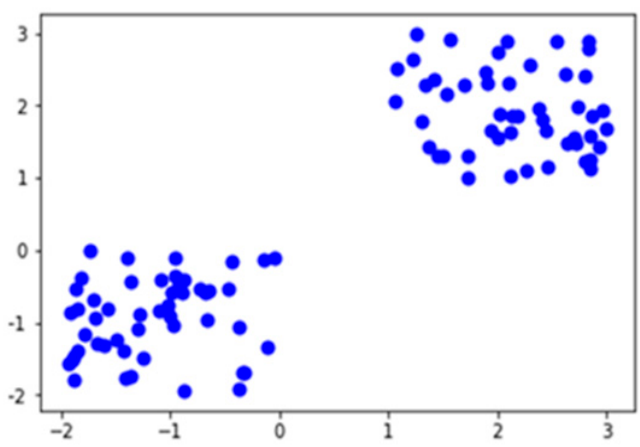
Figure 4. Segmentation of the cluster .